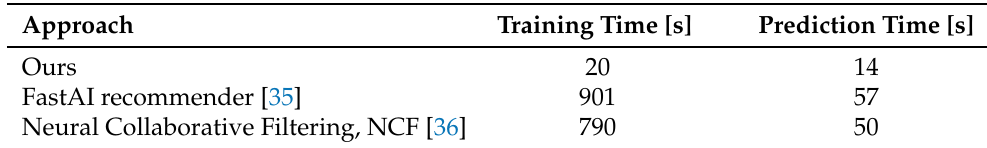
Table 3. Time comparison [s, in seconds]: training and prediction times for data of about 6000 users and 4000 movies (around 23,000,000 user/movie combinations in